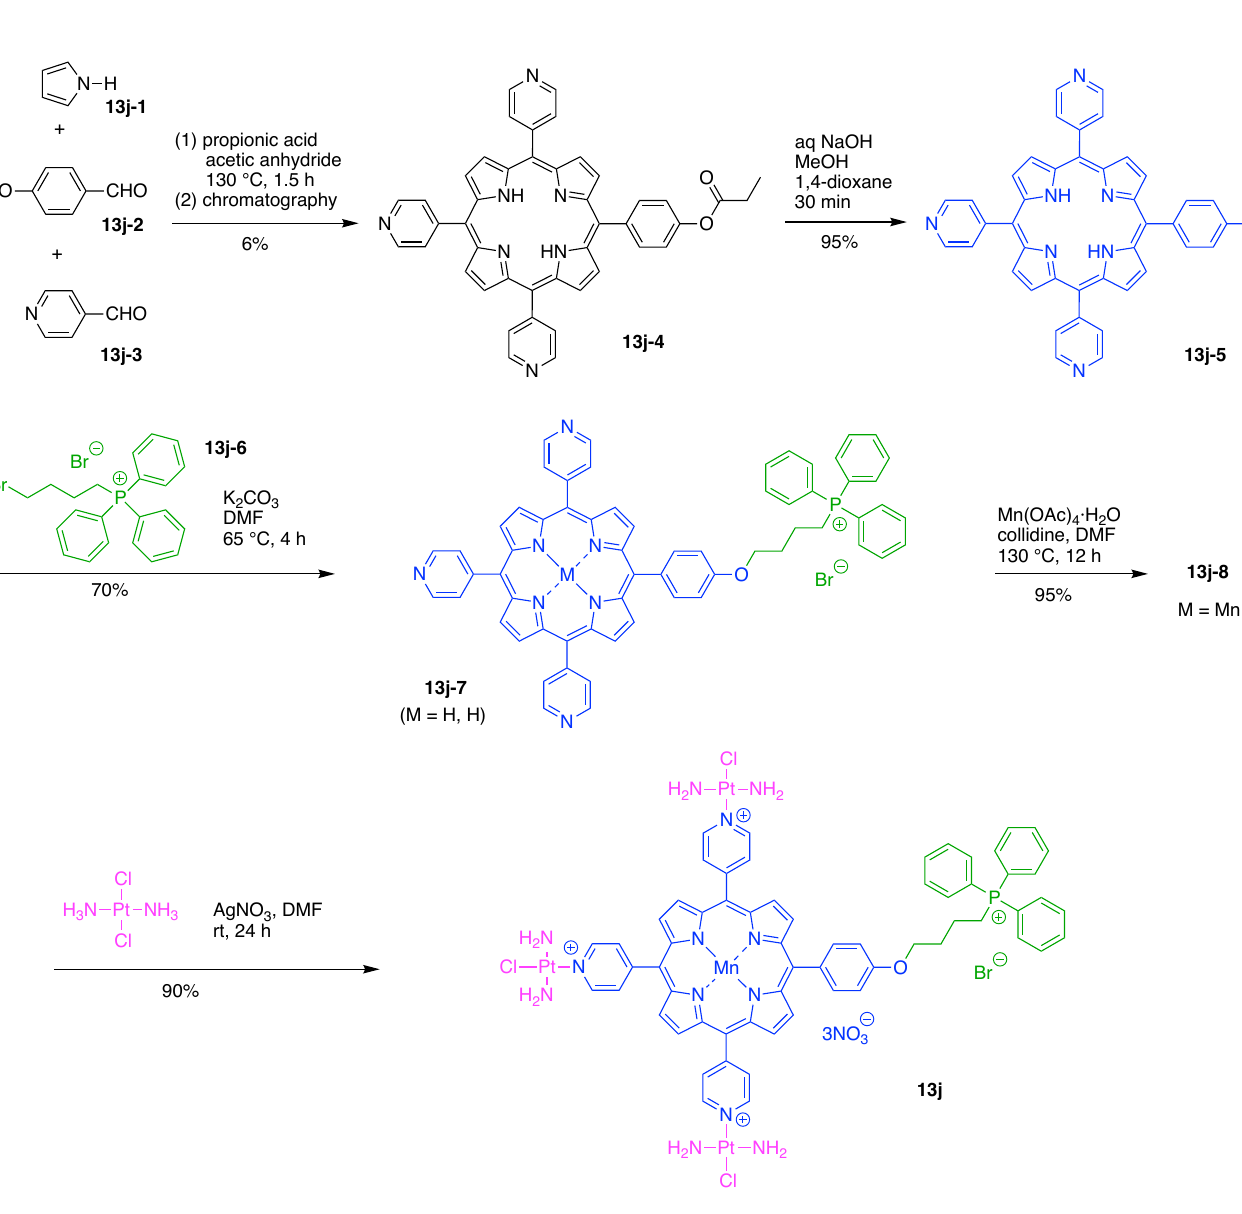
Figure 70. Statistical synthesis of a porphyrin.